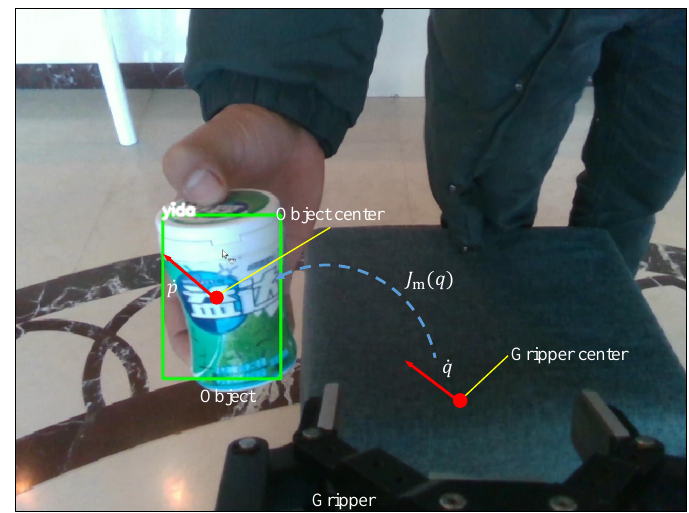
Figure 5. The tracking module based on visual